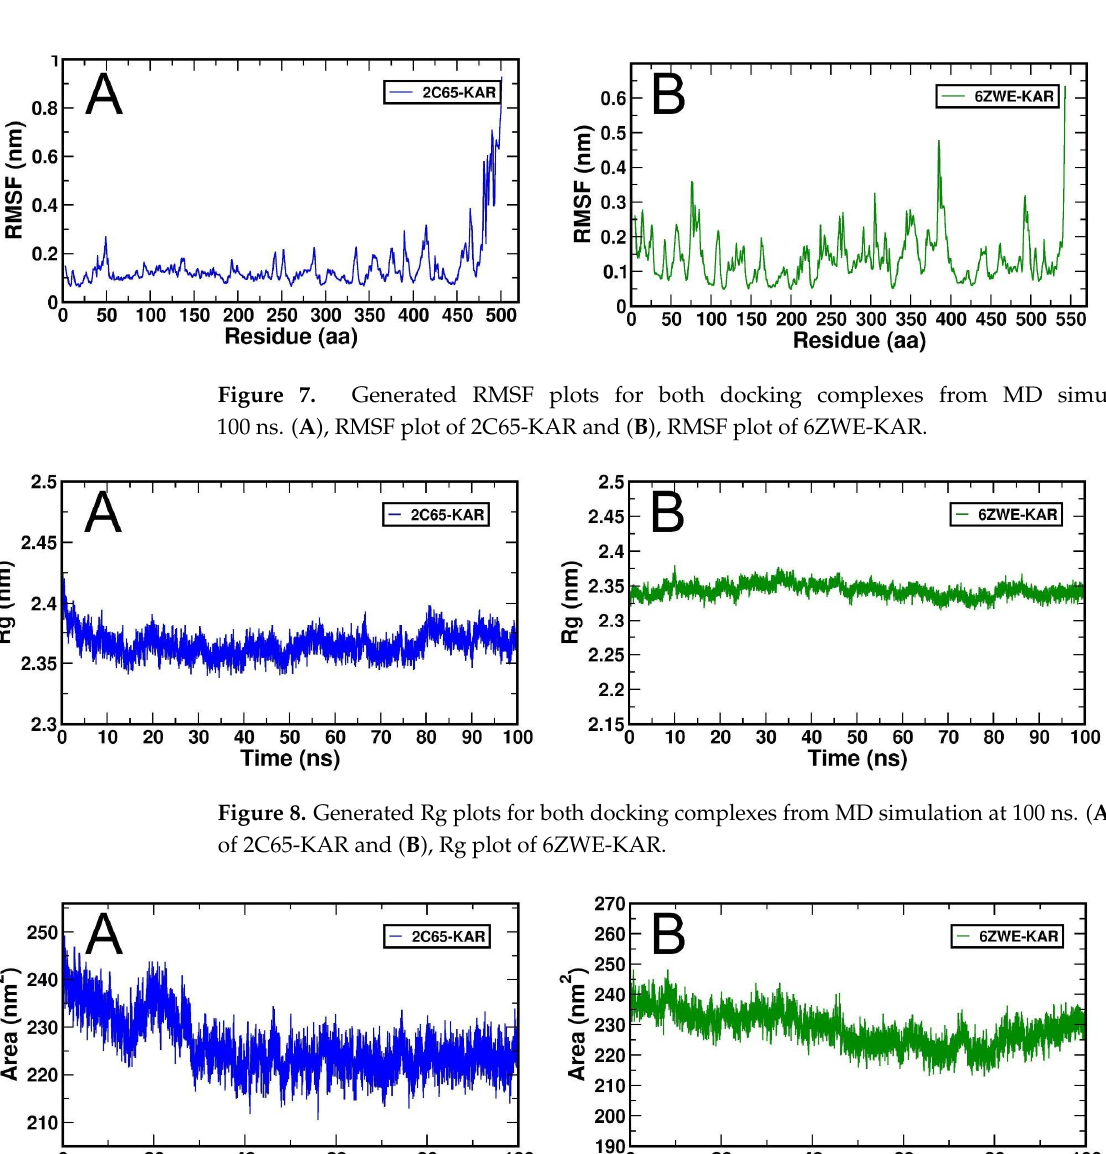
9A), but 6ZWE-KAR continuously deviated in SASA values (Figure 9B). Figure 9. Generated SASA plots for both docking complexes from MD simulation at 100 ns. ( A ), SASA plot of 2C65-KAR and ( B ), SASA plot of 6ZWE-KAR. Overall, each docking complex was stabilized through strong H-bond interactions, with 2C65-KAR (Figure 10A) and 6ZWE-KAR (Figure 10B) also stabilized through H- bonds interactions with both targets. Figure 10. Generated H-bond interaction result for both docking complexes from MD simulation at 100 ns. ( A ), H-bond interaction plot of 2C65-KAR and ( B ), H-bond interaction plot of 6ZWE-KAR. Similarly, distinguished dynamic behaviors of both targets were observed through the widely accepted molecular mechanics Poisson-Boltzmann (MMPBSA) methods, and the results of binding energy of 2C65-KAR and 6ZWE-KAR were − 161.262 kJ/mol and − 168.652 kJ/mol, respectively (Table 3). Thus, the compactness and stability of karinjin with both targets are comparatively similar at 100 ns time scale.